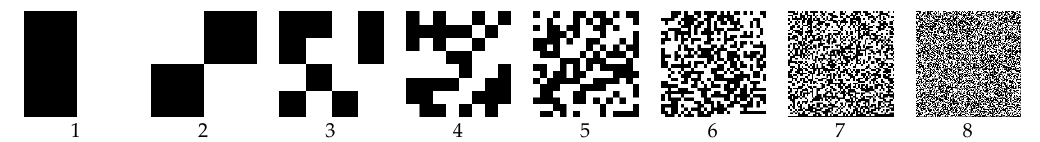
Figure 6. Binary images with different spatial structures, but with the same histogram.